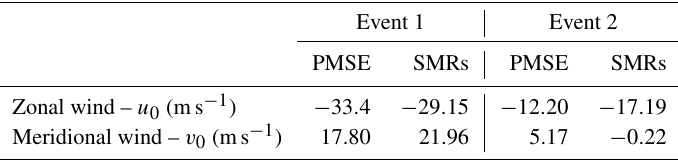
Table 3. Mean wind values for the two events